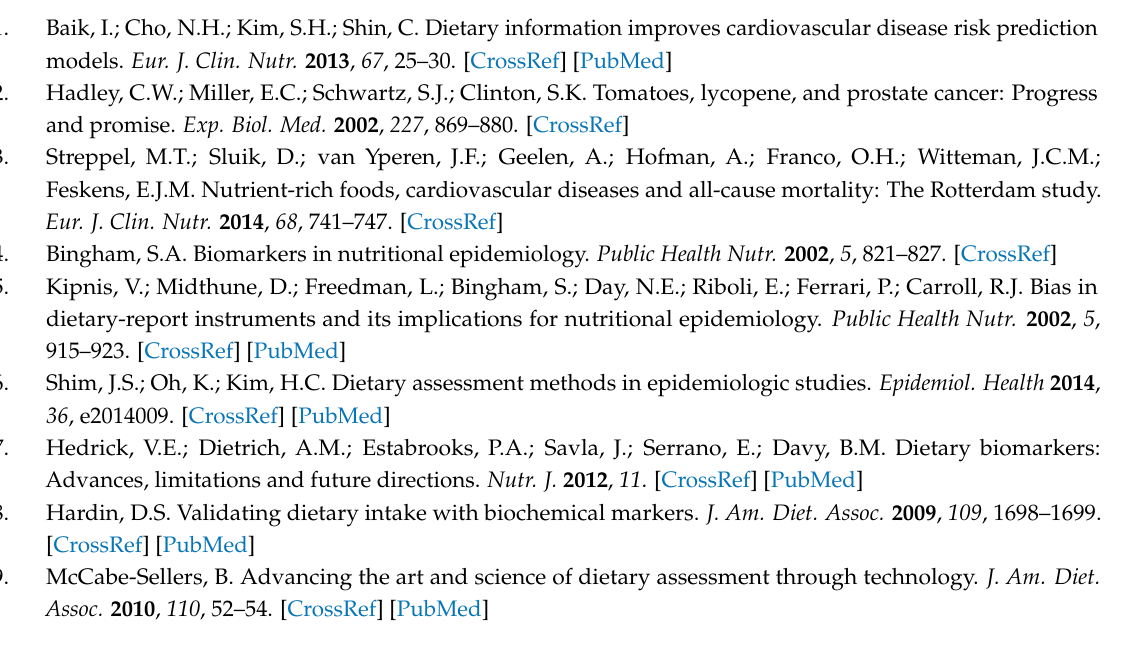
s1, Figure S1: Flow chart of the recruitment of the participants of the discovery study, Figure S2: Principal component analysis (PCA) of UPLC-QTOF/MS urine data of time point 0 ( (cid:4) ) compared with time point 4 h post consumption ( (cid:3) ). Q 2 , 0.217; R 2 X, 0.579; t [1], PLS component 1; t [2], PLS component 2, Figure S3: Variable importance of projection (VIP) score plot ( ≥ 1.5) of 0 h vs. 4 h model (generated from PLS-DA) indicating the most discriminant metabolites in decreasing order. X -axis represents the VIP score and Y -axis indicates features represented with retention time (RT) and mass. The plot was generated from the data obtained from the discovery study, Figure S4: 2-IPMA (A); ASP-Val (B); and NC (C) metabolites showing a differential time-course when pea burger (control) was compared with beef, chicken and pork in an independent study, Table S1: Significant features identified by one-way repeated measures ANOVA in Negative ion mode, Table S2: Significant features identified by one-way repeated measures ANOVA in Positive ion mode, Table S3: Dose–response study population